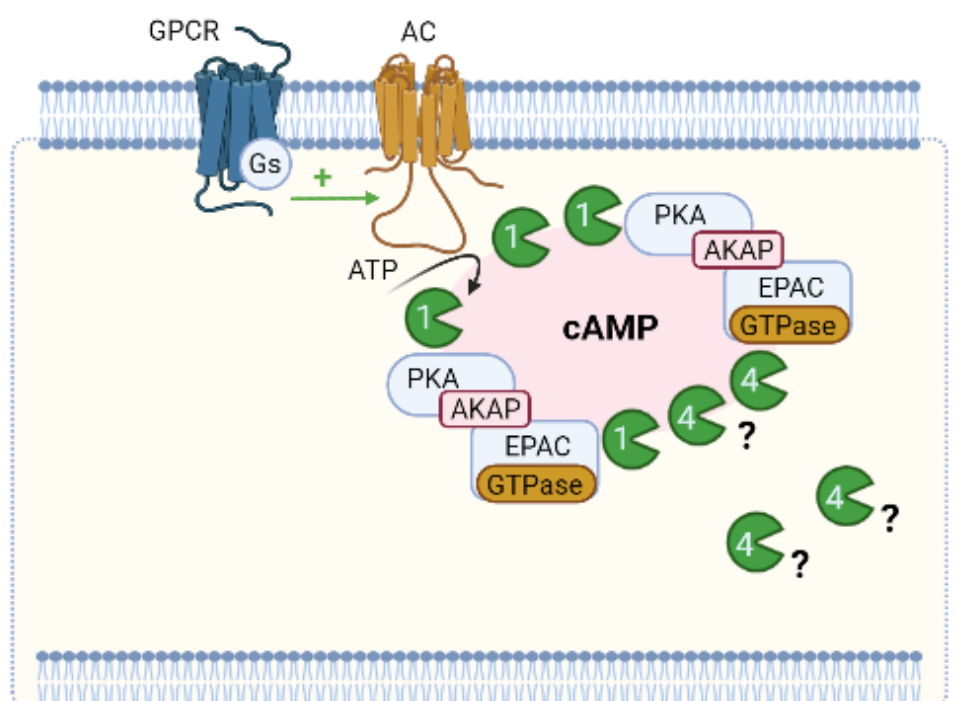
Figure 5. Schematic representation of compartmentation of cAMP signalling in vascular SMCs in a synthetic phenotype (created with biorender.com). In the synthetic phenotype, activating GPCR leads to a pool of cAMP mainly controlled by